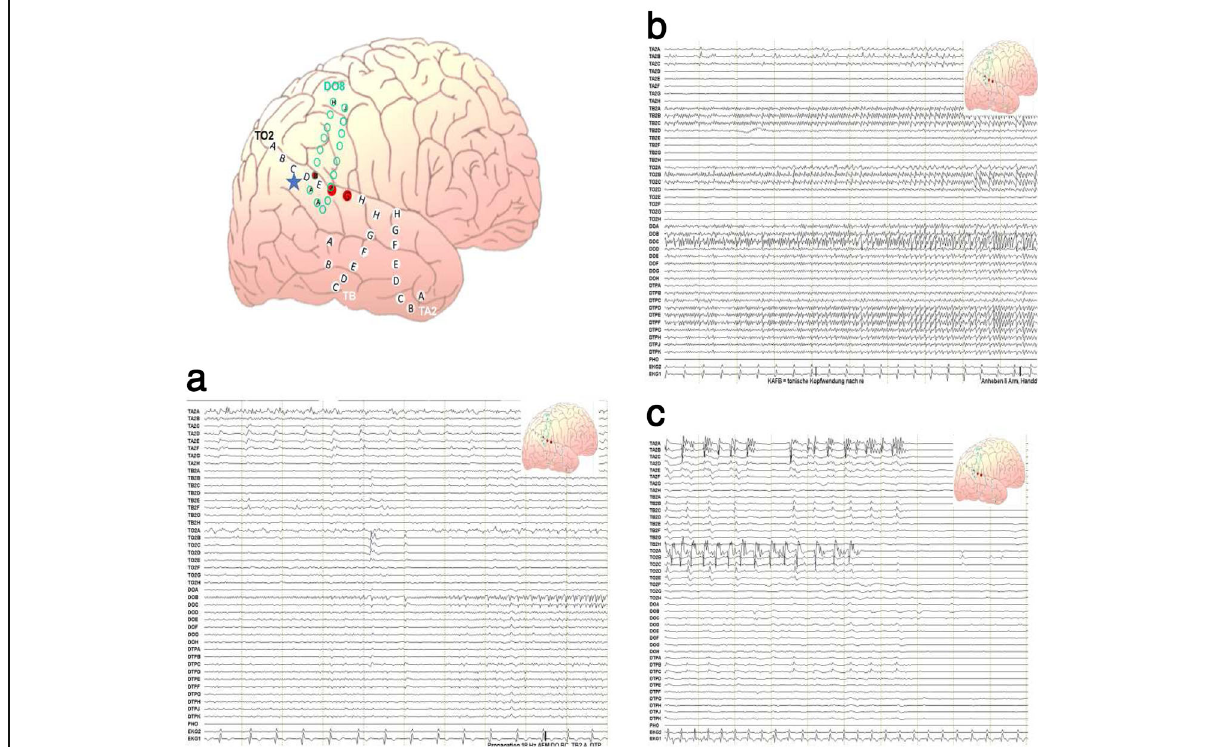
Fig. 1 Invasive electrodes, red seizure onset electrode contacts. MEG localization and different epochs during the seizure. Red: seizure onset in invasive electrodes a Ictal onset of seizure discharges parietal right. b + c Propagation to temporal